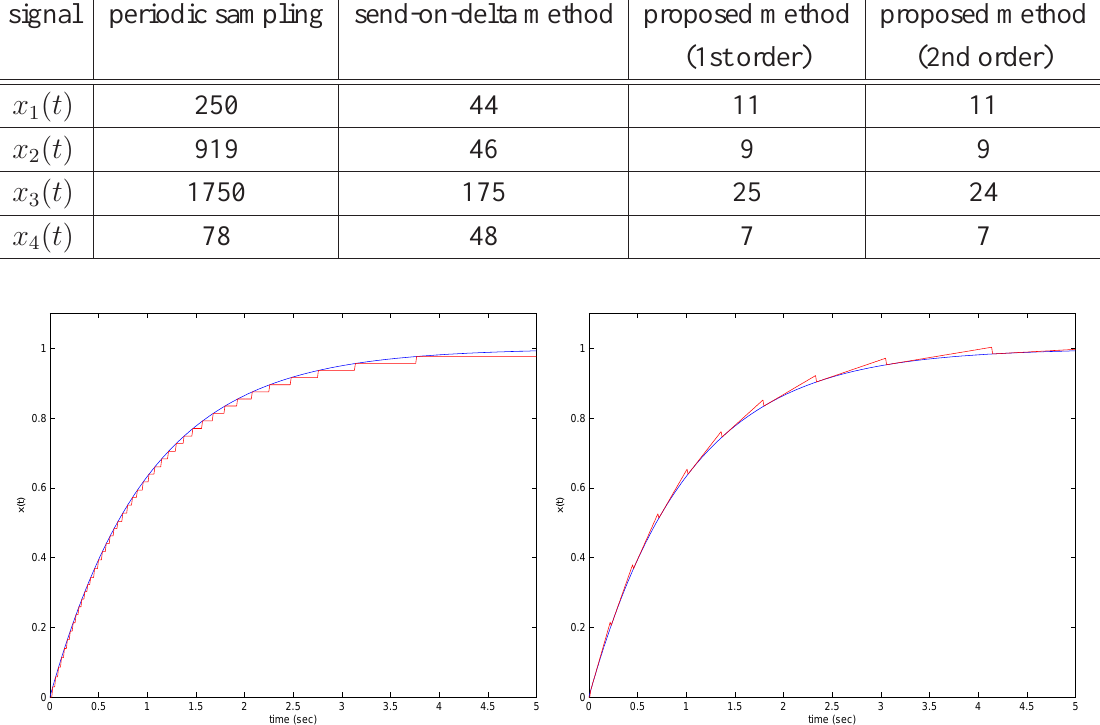
( t ) plot with the send-on-delta method (left) and the proposed method (right) Figure 6 . x 1